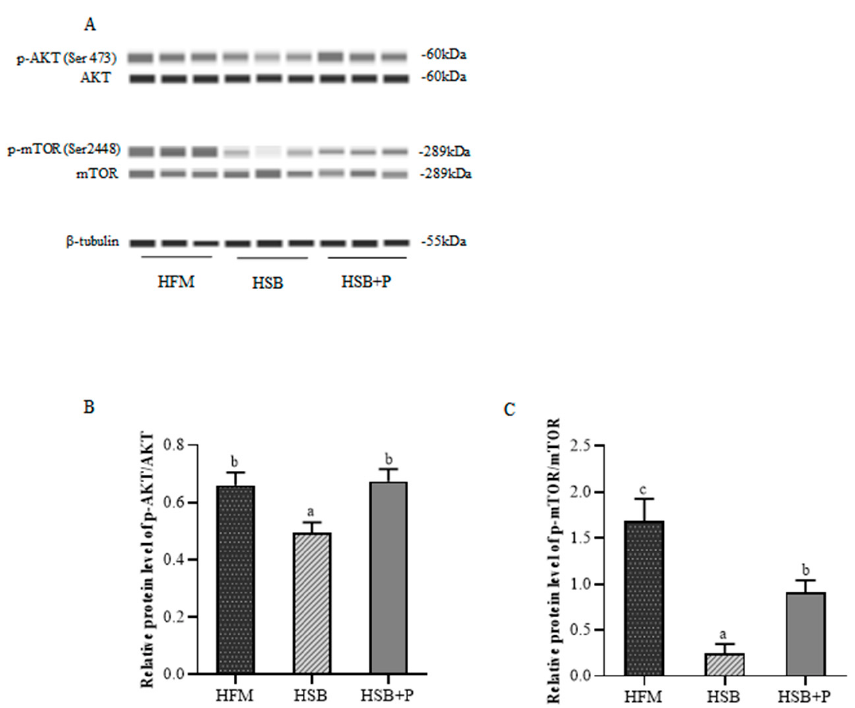
Figure 3. Western blot results of total and phosphorylated AKT and mTOR (Mean ± SEM, n = 3).